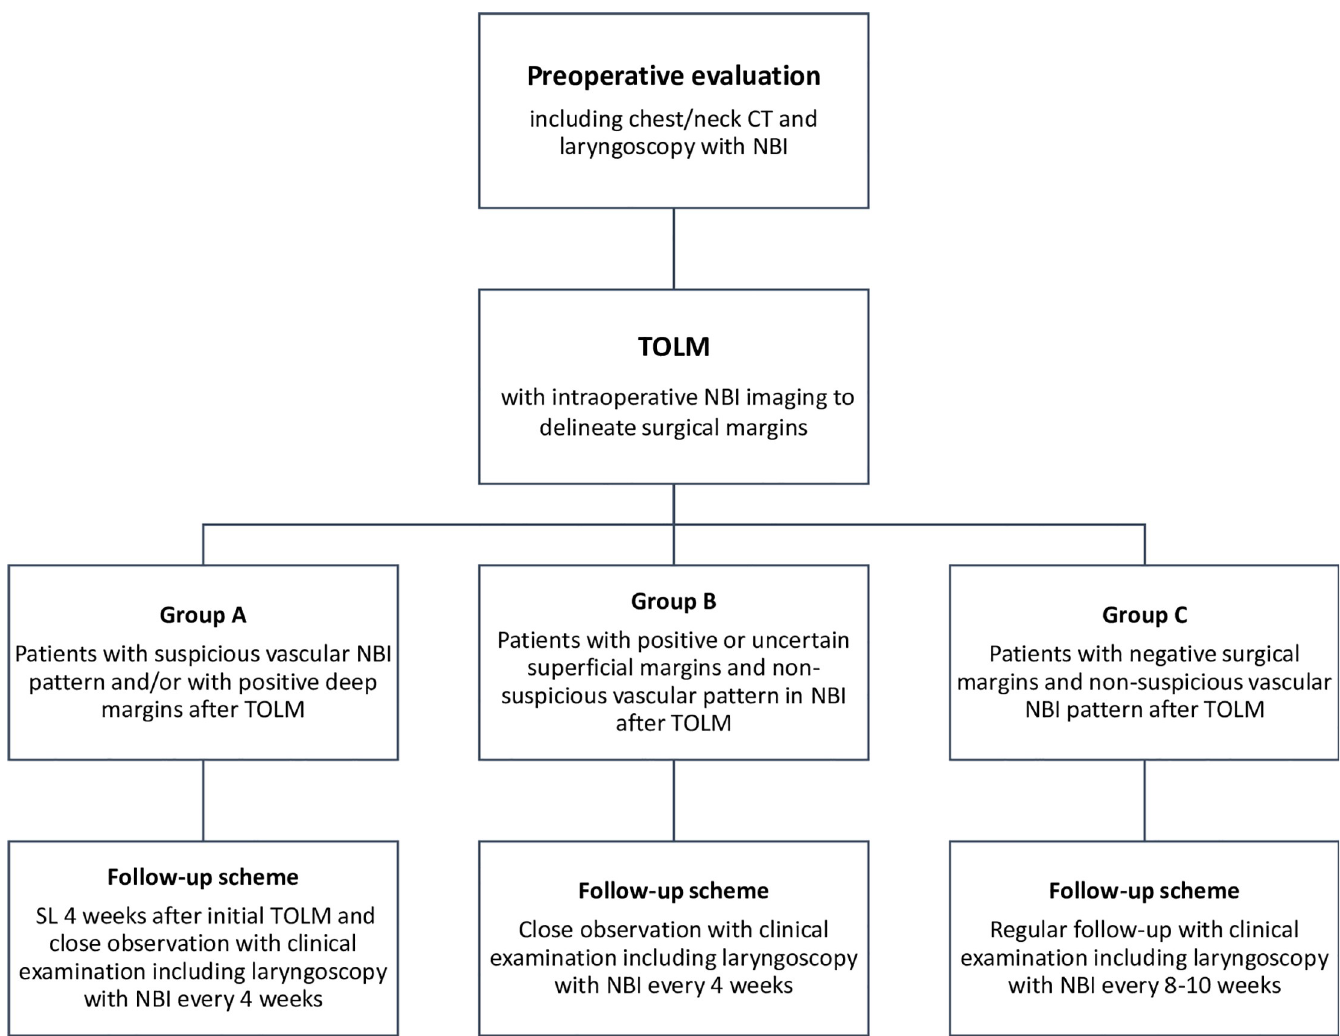
Fig 1. Study protocol. Abbreviations: CT–computed tomography, NBI–narrow band imaging, TOLM–transoral laser microsurgery.